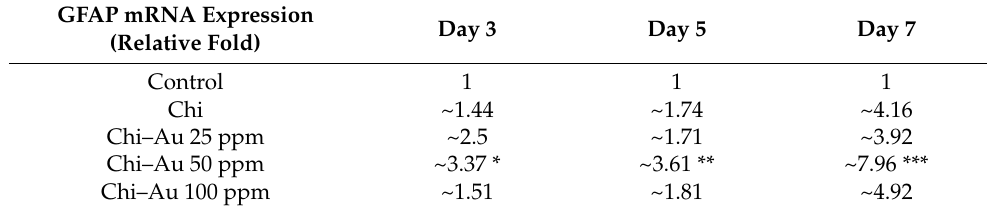
Figure 5. The mRNA expression of various differentiation markers in MSCs cultured on Chi–Au nanocomposites was investigated using real-time PCR at 3, 5, and 7 days. ( A ) The expression of the neural differentiation markers GFAP, β -Tubulin and nestin were semi-quantified. The results indicated that Chi–Au 50 ppm significantly induced neural differentiation. ( B ) The expression of the endothelialization markers CD31 and vWF were semi-quantified. CD31 and vWF mRNA were significantly expressed when treated with Chi–Au 25 ppm. The results are demonstrated as mean ± SD ( n = 3). * p < 0.05, ** p < 0.01, *** p < 0.001: compared with the control (TCPS). Tabulation Data of mRNA Expression Induced by Chi–Au Nanocomposites. Table 1. GFAP mRNA expression at 3, 5, and 7 days.